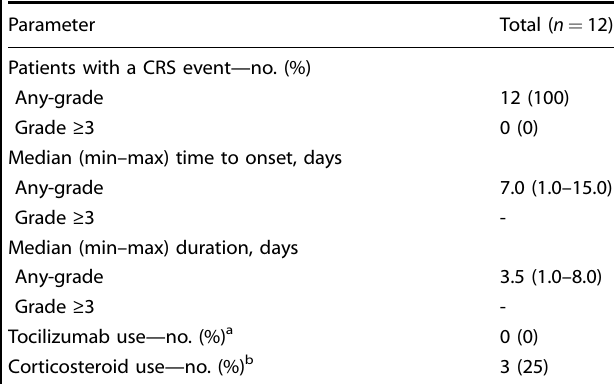
Table 2. Adverse events, cytokine release syndrome, and neurologic Table 3. Characteristics and management of cytokine